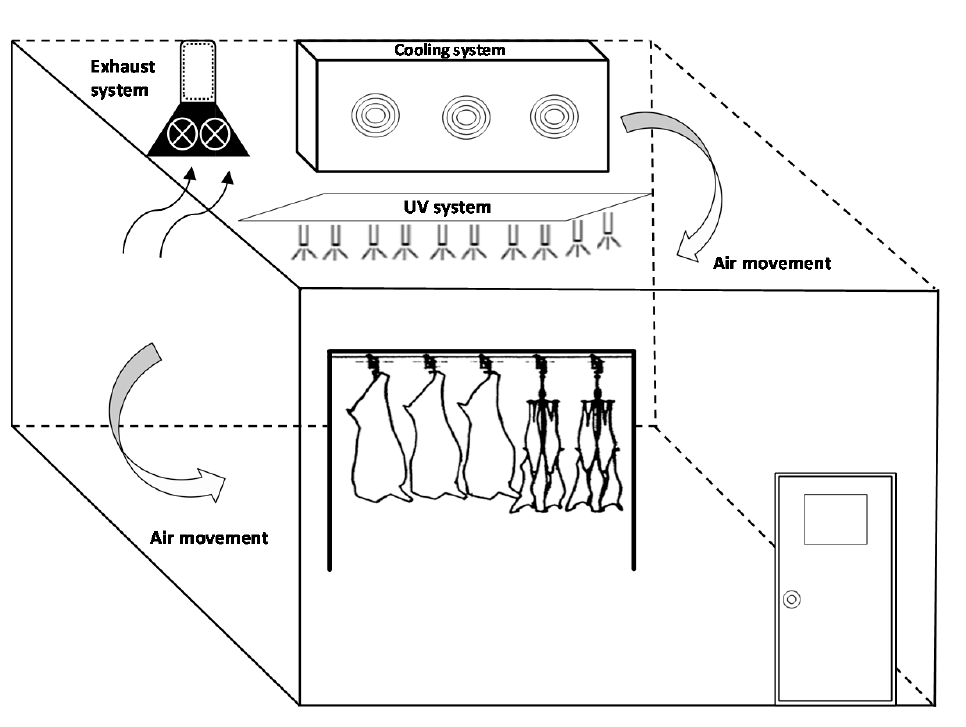
Figure 2. Schematic design of UV treatment in a meat cold storage room.